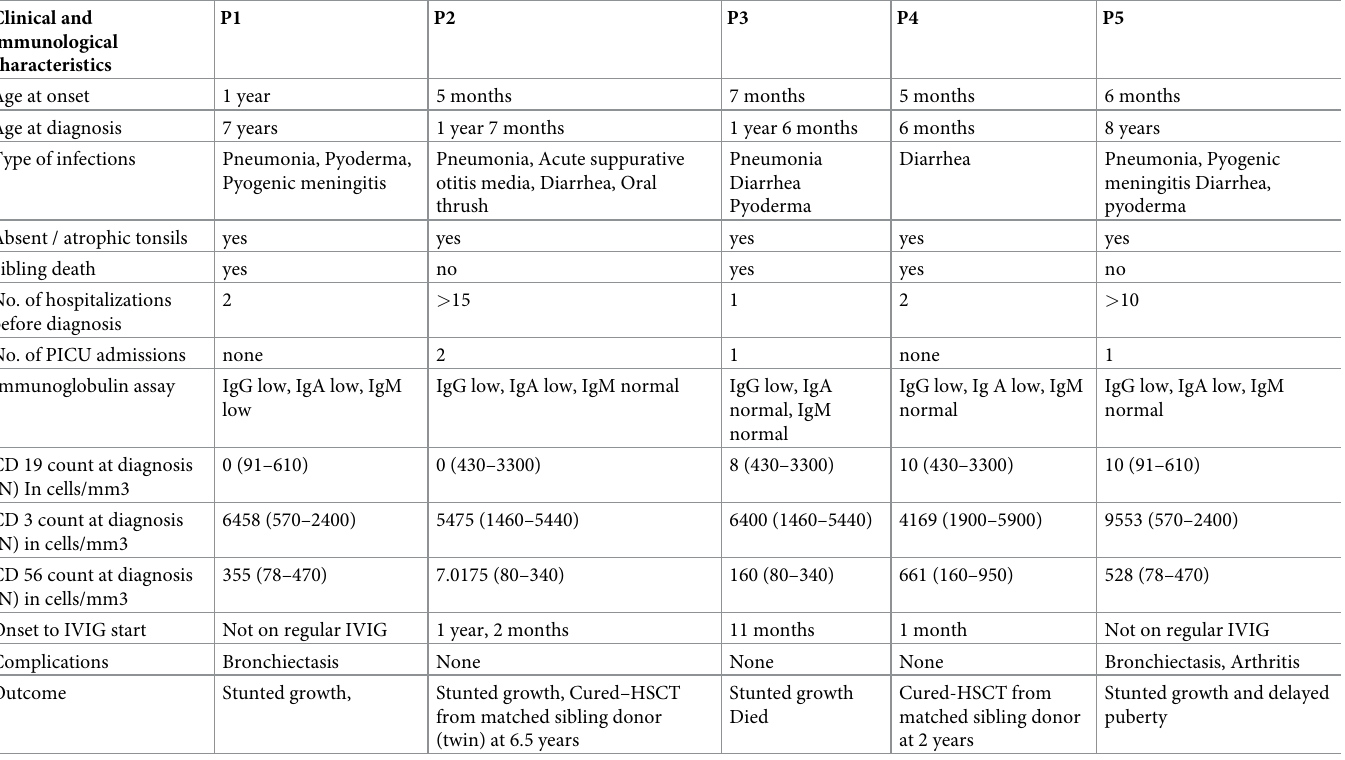
Table 1. Clinical and Immunological features of patients with XLA in the present